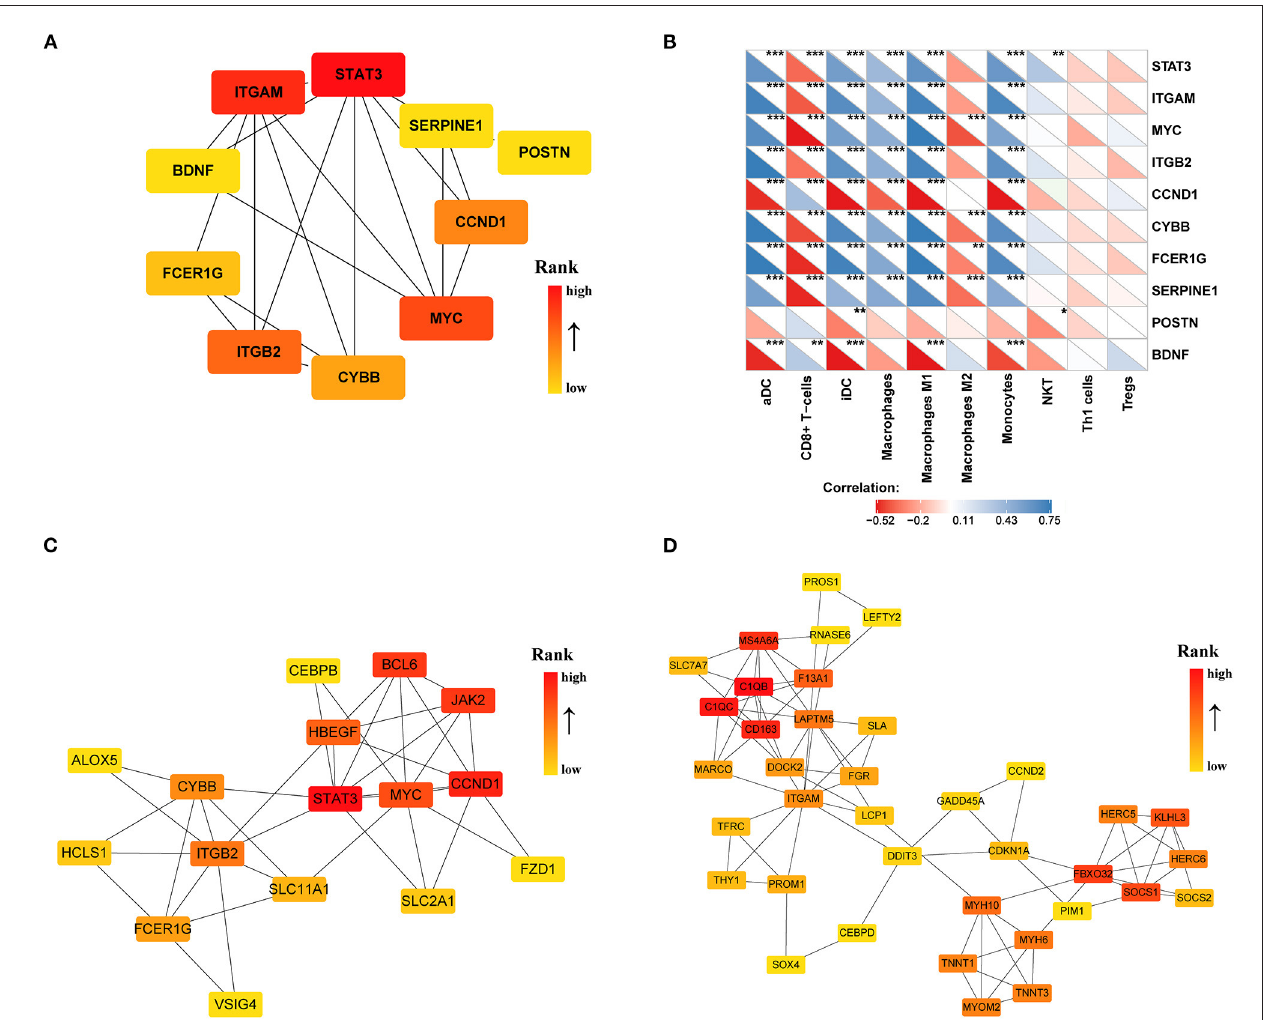
FIGURE 6 | PPI network of DEGs (|log2FC| > 0.5) in the GSE36961 and GSE141910 dataset. (A) Top 10 hub genes in DEGs. (B) Correlation matrix of xCell scores of immune cell subtype with top 10 hub genes. (C,D) Two highly interconnected clusters recognized by MCODE in DEGs. * p < 0.05, ** p < 0.01, *** p <